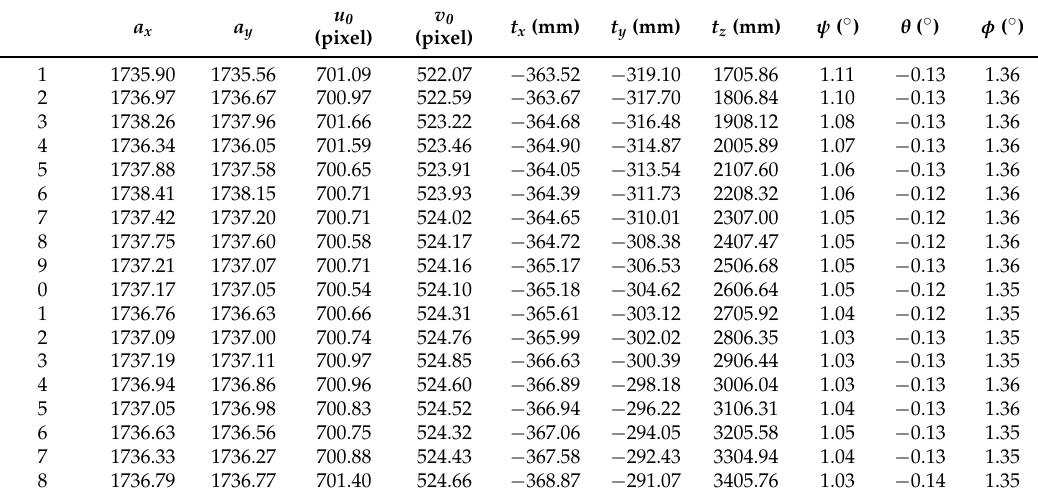
Table 2. IDLT results of the physical